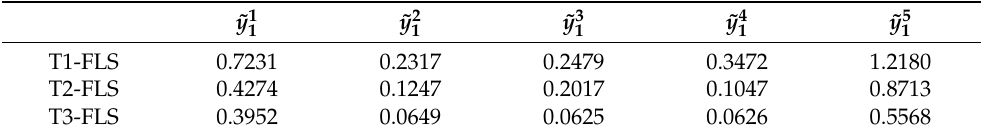
Table 3. Example 2: Comparison results.